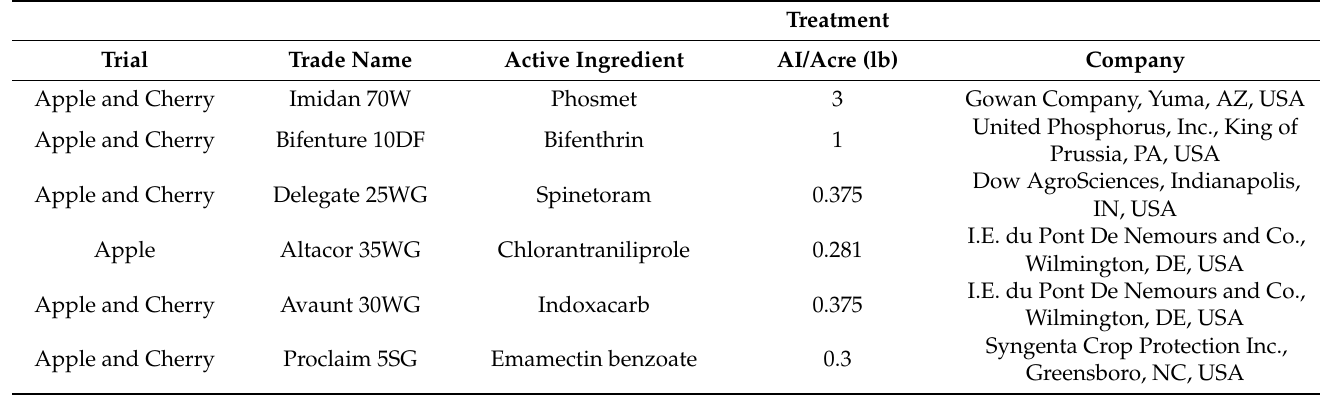
Table 1. The details of the compounds that were tested in apple and cherry field